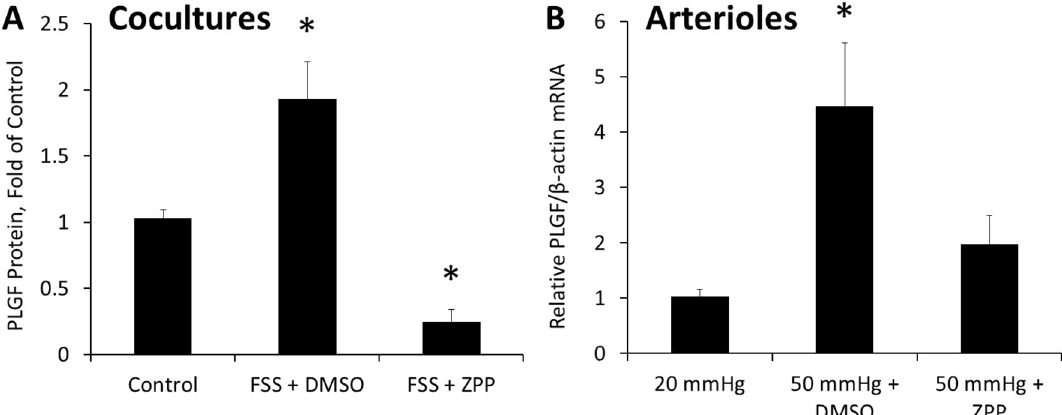
Figure 2. HO-1 activity is necessary for FSS to increase PLGF expression. ( A ) In co-cultures, ZPP (30 µM) inhibited the increase in secreted PLGF observed following exposure to FSS (n = 5, p < 0.05). ( B ) In mesenteric arterioles, perfusion at a pressure gradient of 50 mm Hg for 2 h increased PLGF mRNA compared to perfusion at 20 mmHg. This increase was blunted by ZPP (30 µM) (n = 5, p <